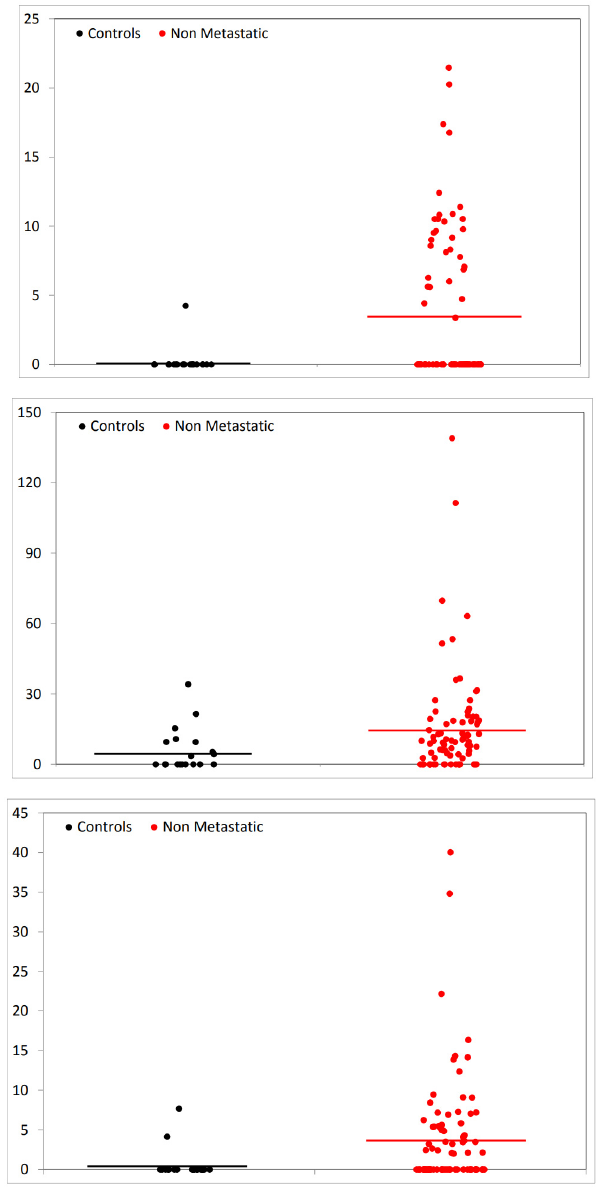
Figure 2. Dot plots representing abundance values for controls and non-metastatic patients. From top to bottom, plots refer to signals m/z 1561.72, 2021.08 and 2399.17. Dots on the left (black) represent controls, dots on the right (red) non-metastatic patients. The horizontal lines show the average values. Dots are randomly spread along the abscise axis for visibility. Scales are adapted to values.